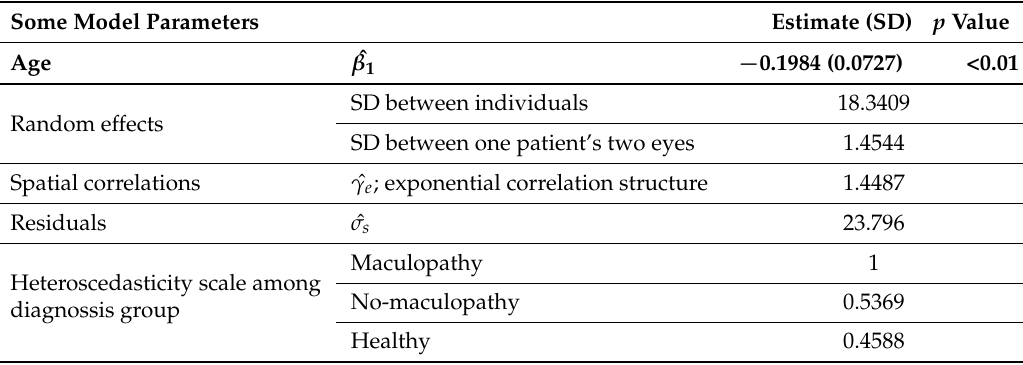
Table 4. Estimates for age, standard deviations of random effects, estimators for random effects and residuals, and heteroscedasticity range in the final model.